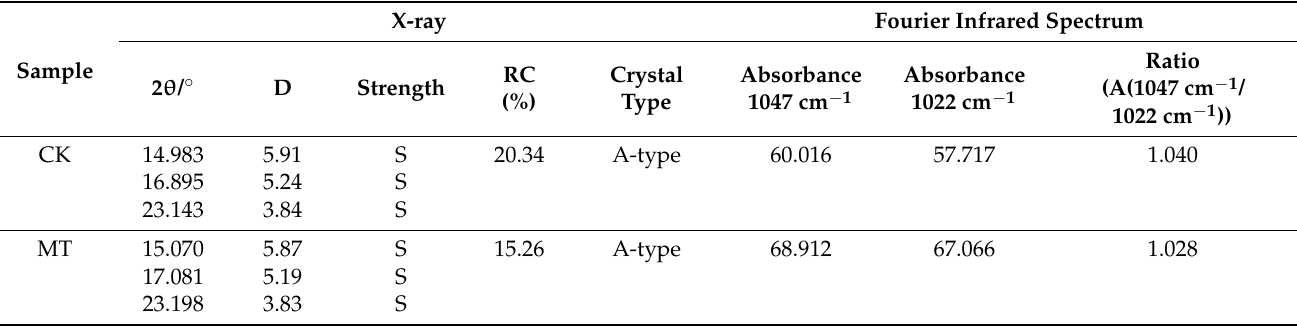
Table 8. X-ray diffraction patterns and Fourier infrared spectrum of microwave pre-cooked adzuki beans